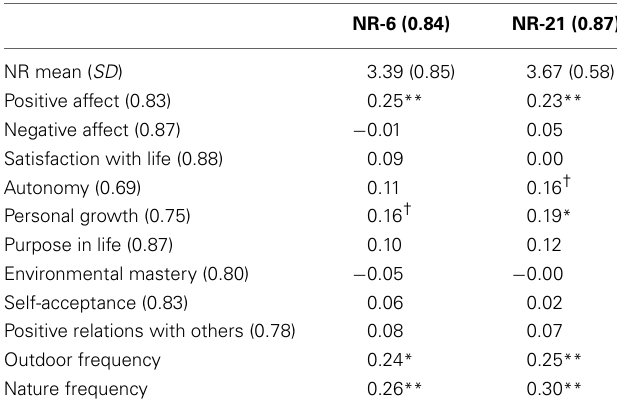
Table 2 | Study 2—nature relatedness correlations with well-being and nature contact measures in middle managers ( N =